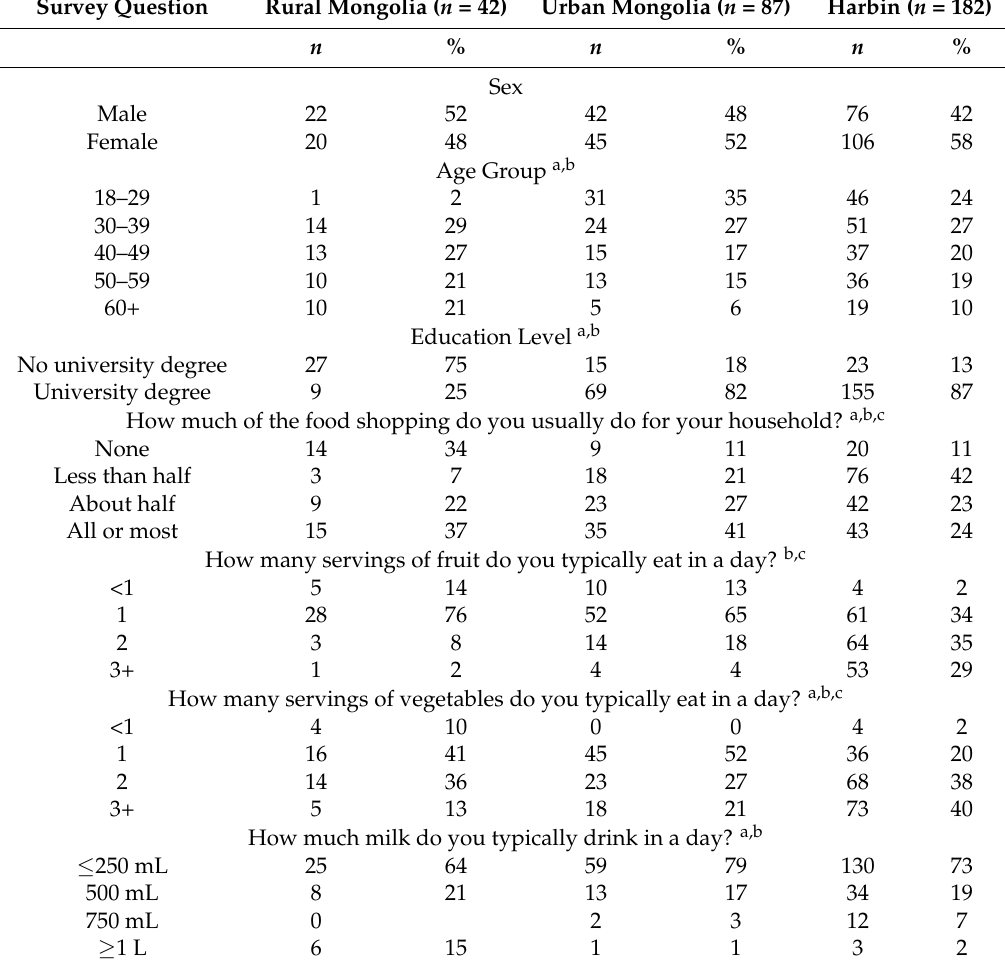
Table 1. Characteristics of study